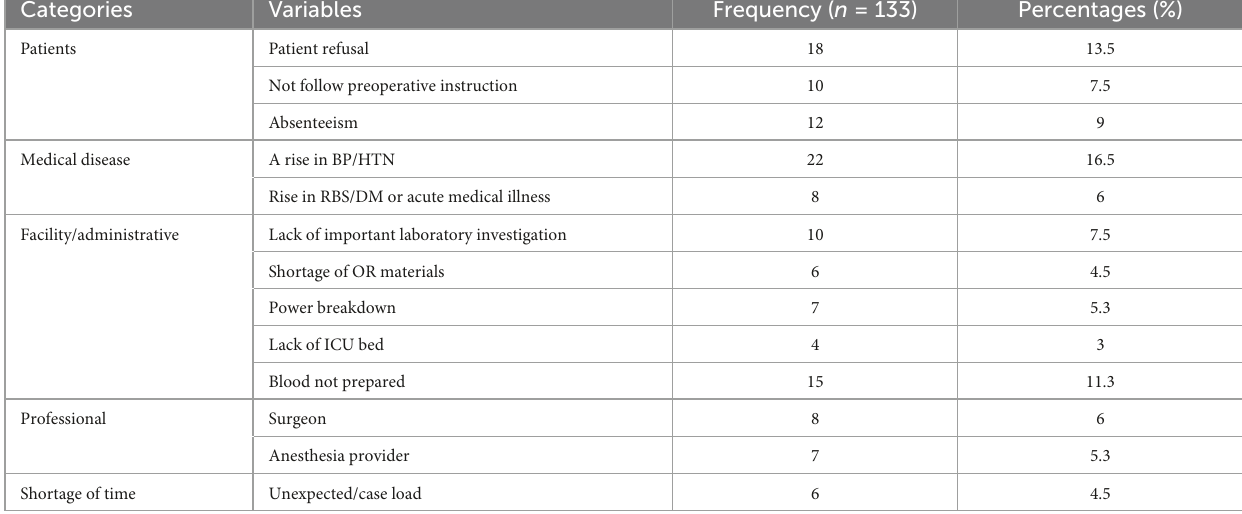
TABLE 2 Reported reasons for cancellation of elective surgery in public hospitals in Harari regional state, Eastern Ethiopia ( n =